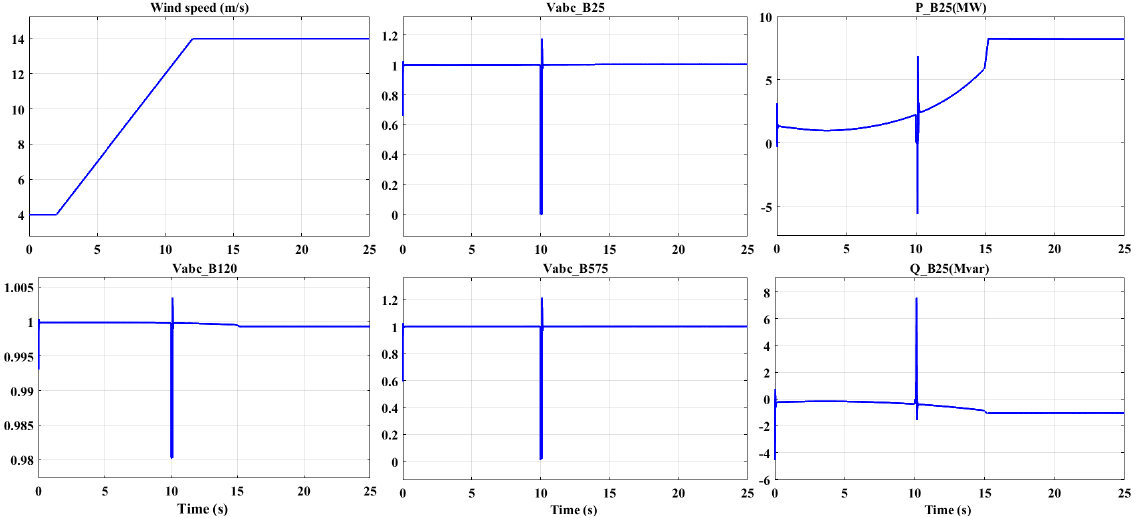
Figure 15. DFIG grid parameters at three-phases short circuit fault for 0.1 s.